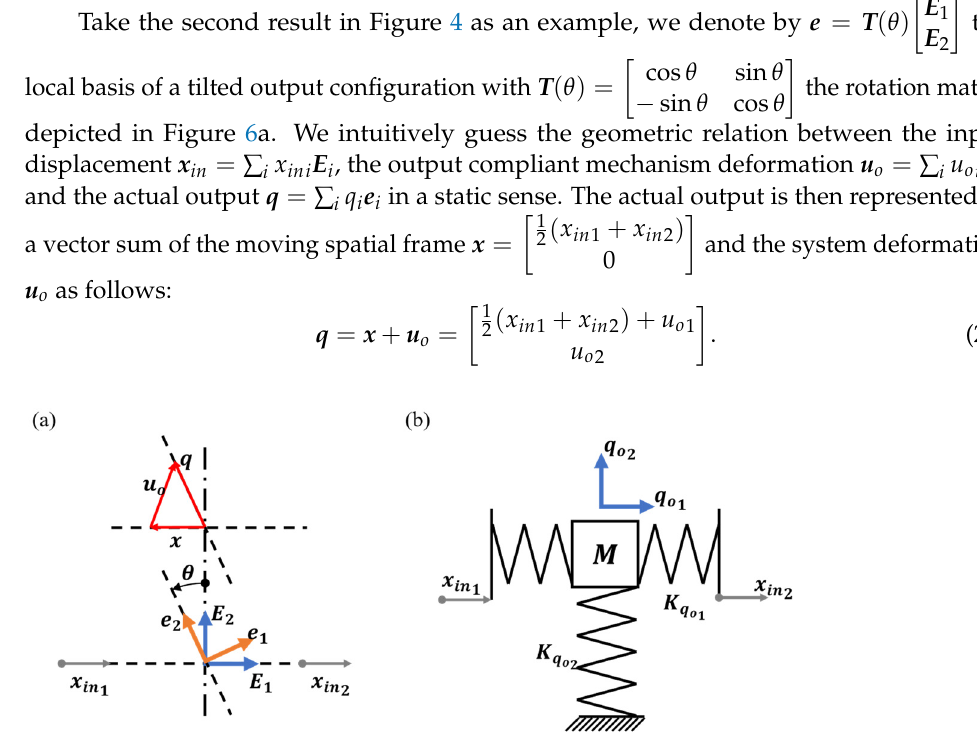
Figure 6. Schematic illustrations of ( a ) The 2nd-order spring–mass model of the compliant mechanism and ( b ) The tilted output configuration with rotation angle of θ .